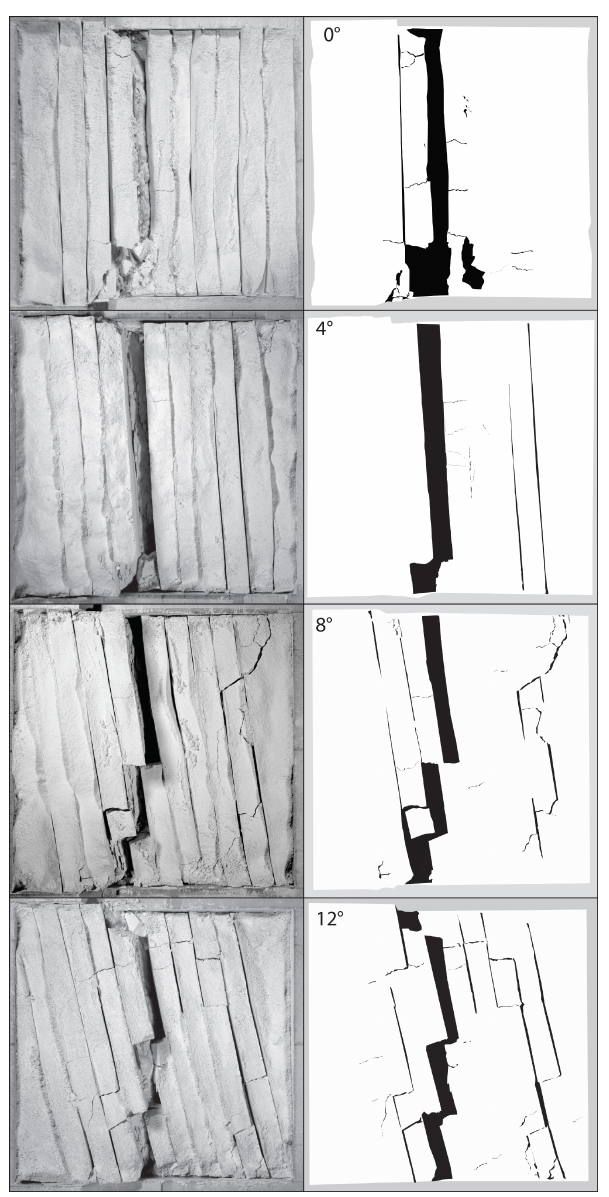
Figure A1. Top-view photographs and interpretation for experi- ments with 0, 4, 8 and 12 ◦ JF-angle.